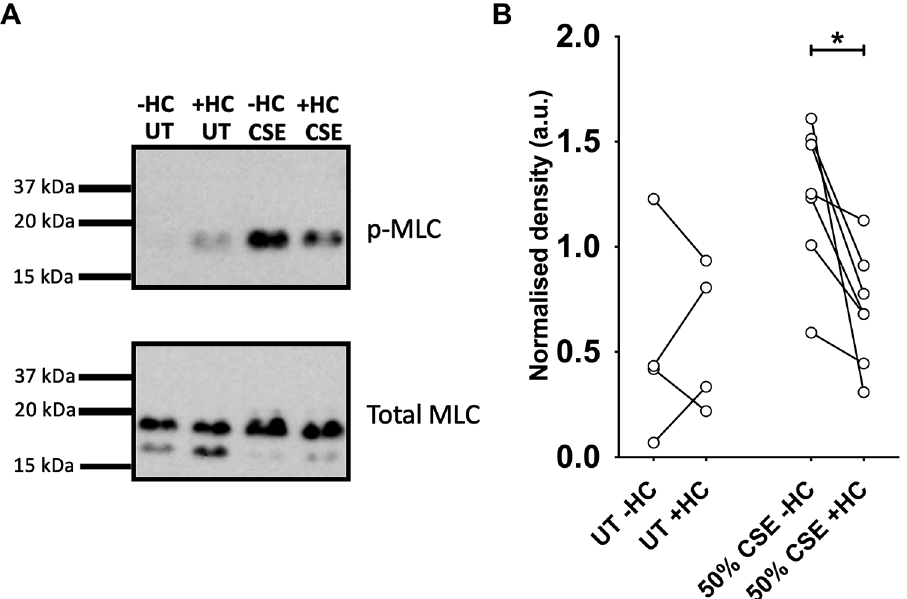
Figure 7. CSE induces MLC phosphorylation in hASMC, downstream of TRPA1-mediated Ca 2+ influx. Cells were equilibrated with HEPES-buffered solution for 1 h, and lysed after treatment for protein extraction. For the negative control samples without CSE exposure (UT; untreated), cells were treated with 0.1% DMSO (−HC) or 50 µM HC-030031 (+ HC) for 15 min before lysis. For the CSE experiments, cells were pre-treated with 0.1% DMSO (−HC) or 50 µM HC-030031 (+ HC) for 15 min, and then exposed to 50% CSE, with or without HC-030031, for 2 min before lysis. 15 µg of protein was loaded into each well for gel electrophoresis and western blot analysis. (A) Representative western blot image for MLC phosphorylation assay described above. All 8 lanes shown were part of the same blot, cut vertically to perform staining with two different antibodies. The 4 lanes in the top panel (p-MLC) match the 4 lanes in the bottom panel (total MLC), i.e. the same protein sample run on the same gel, processed under identical blotting and exposure conditions. Full uncropped blots are presented in Supplementary Fig. 1. (B) Semi-quantitative paired comparison of CSE-induced phospho-MLC protein levels, with or without pre-treatment with HC-030031. Band density of p-MLC was normalised to the density of total MLC of the same protein sample (3 independent donors; n = 4–7). *p < 0.05, Wilcoxon matched-pairs signed rank